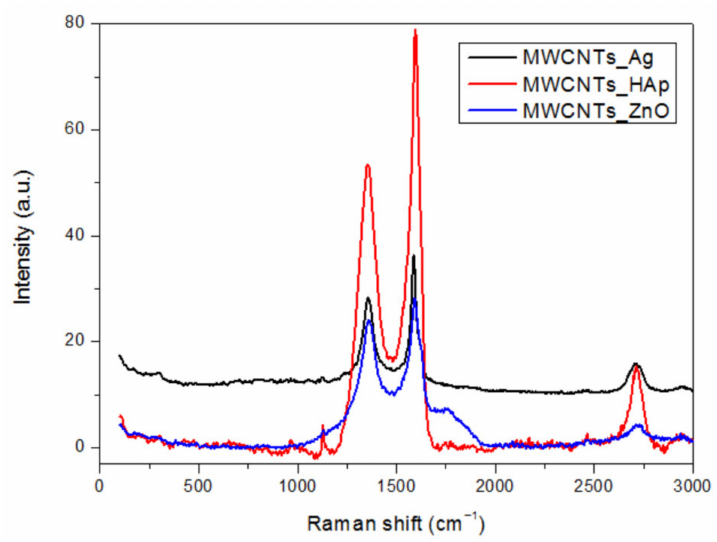
Figure 3. Raman spectra of MWCNTs decorated with NPs.